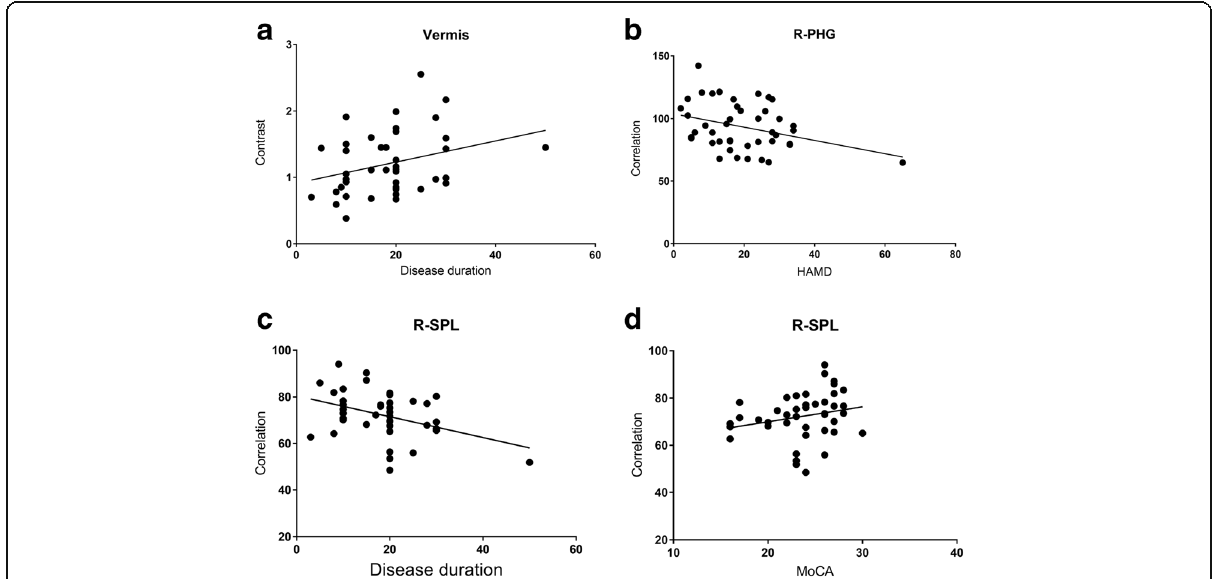
Fig. 6 Scatter plot of texture parameters with clinical variables. a Increased Contrast of vermis presented significant positive relation with disease duration in MOH; b Increased Correlation of right parahippocampal gyrus (R-PHG) presented significant negative relation with HAMD score; c Decreased Correlation of right superior parietal lobule (R-SPL) presented significant negative relation with disease duration; d Decreased Correlation